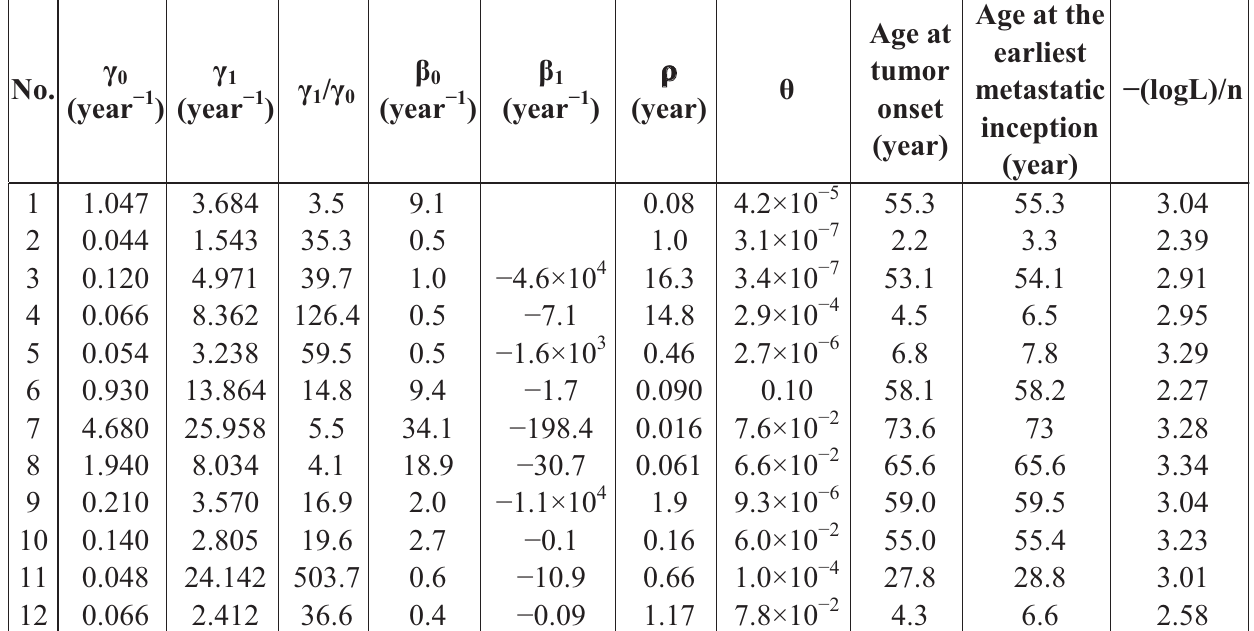
Table 3. Biological parameters of the full